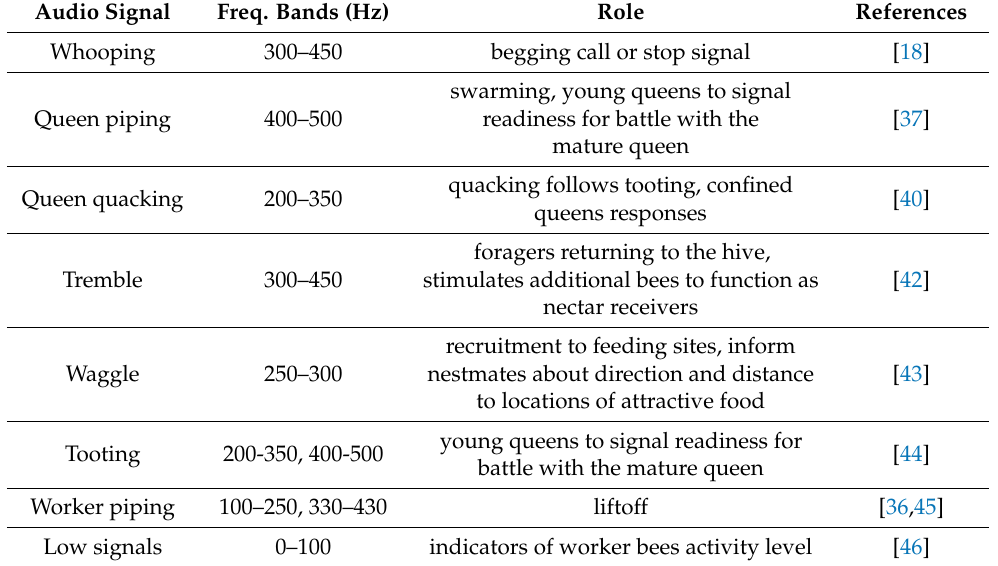
Table 1. Vibrational patterns of bees and their